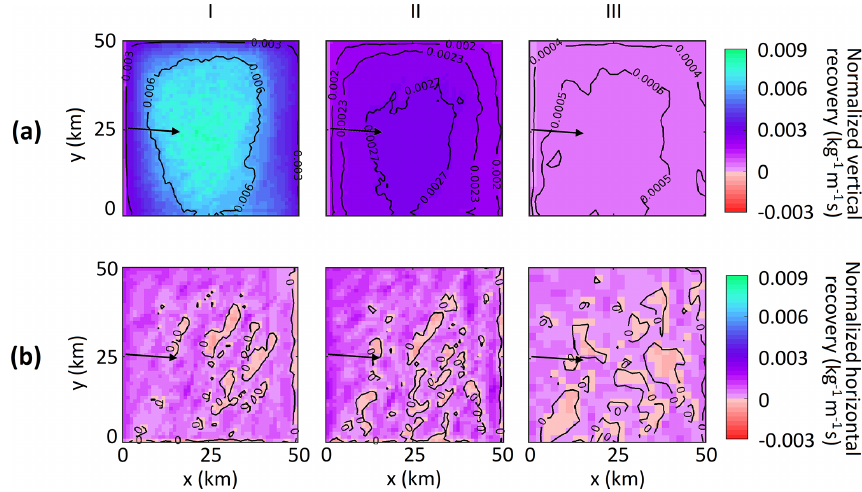
Figure 8. (a) Vertical recovery (normalized by power) and (b) horizontal recovery (normalized by power) for case with (I) 0.5km, (II) 1km, and (III) 2km turbine spacings over the wind farms. The black arrow represents the prominent wind direction. Vertical and horizontal recovery are averaged over 5 sea-breeze days for 12:30 to 17:30IST. Table 4. Momentum loss rate ( × 10 − 3 ), ms − 2 , vertical recovery ( × 10 − 3 ), ms − 2 , and horizontal recovery ( × 10 − 3 ), ms − 2 averaged over the wind farm and sea breeze hours. The numbers in the parenthesis give the percentage recovery with respect to the corresponding momentum loss rate. Cases I II III Momentum Loss Rate − 1 . 212 − 0 . 534 − 0 . 165 Vertical Recovery 0.651 (53.7%) 0.277 (51.9%) 0.083 (50.3%) Horizontal Recovery 0.057 (4.7%) 0.061 (11.4%) 0.032